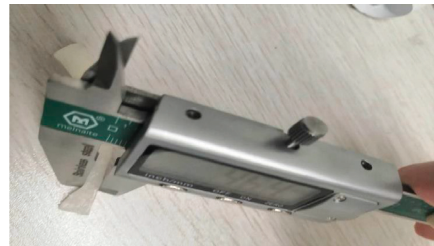
Figure 7: Measuring process using a vernier caliper.